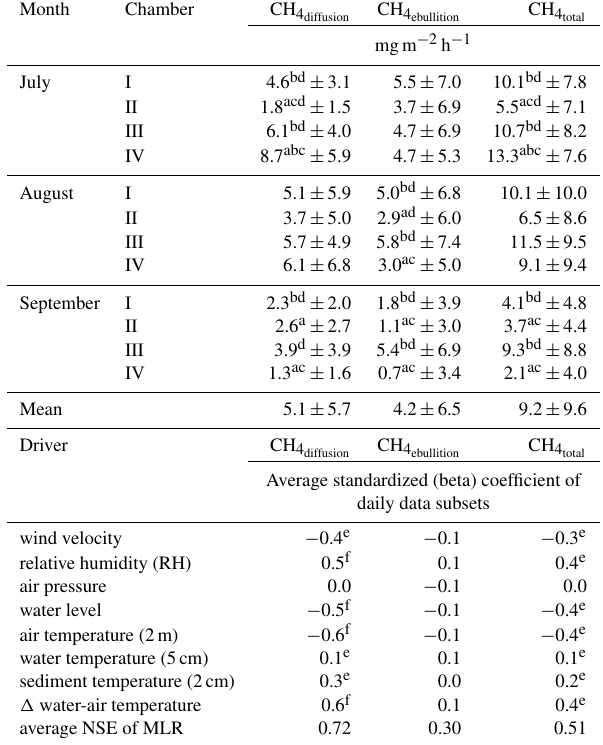
Table 1. Monthly averages ± 1 standard deviation of hourly CH 4 emissions (mgm − 2 h − 1 ) for the chamber transect (from chamber I–IV, starting near the shoreline). Average standardized (beta) coef- ficients and Nash–Sutcliffe efficiency (NSE) based on linear regres- sions and multiple linear regressions between different environmen- tal drivers and daily subsets of calculated CH 4 emissions are shown below. Monthly averages as well as statistics are separated accord- ing to diffusion, ebullition and total CH 4 flux. Superscript letters indicate significant differences between chambers and the p values of applied linear and multiple linear regressions (MLRs). Month